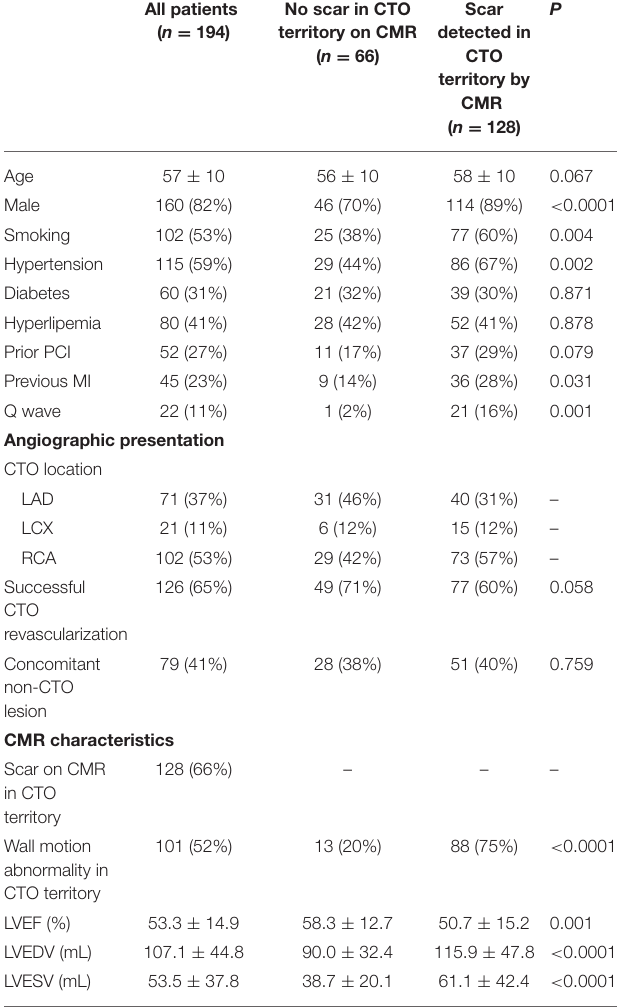
TABLE 1 | Baseline